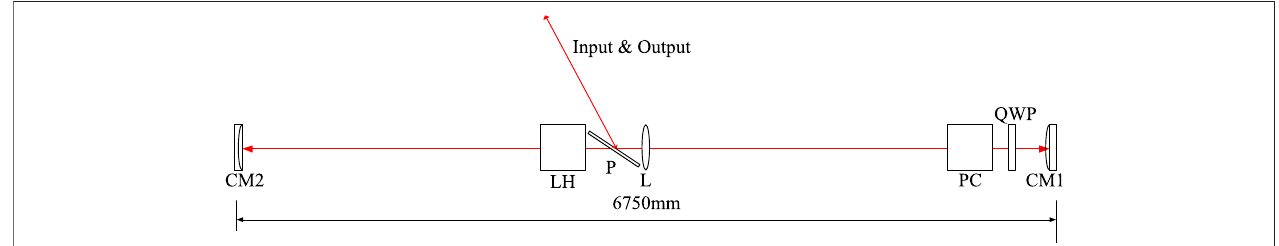
FIGURE 1 | Simpli fi ed regenerative ampli fi er concept. CM1 and CM2: cavity mirrors; LH: laser head; P: thin- fi lm polarizer; L: lens; PC: Pockels cell; QWP: quarter- wave